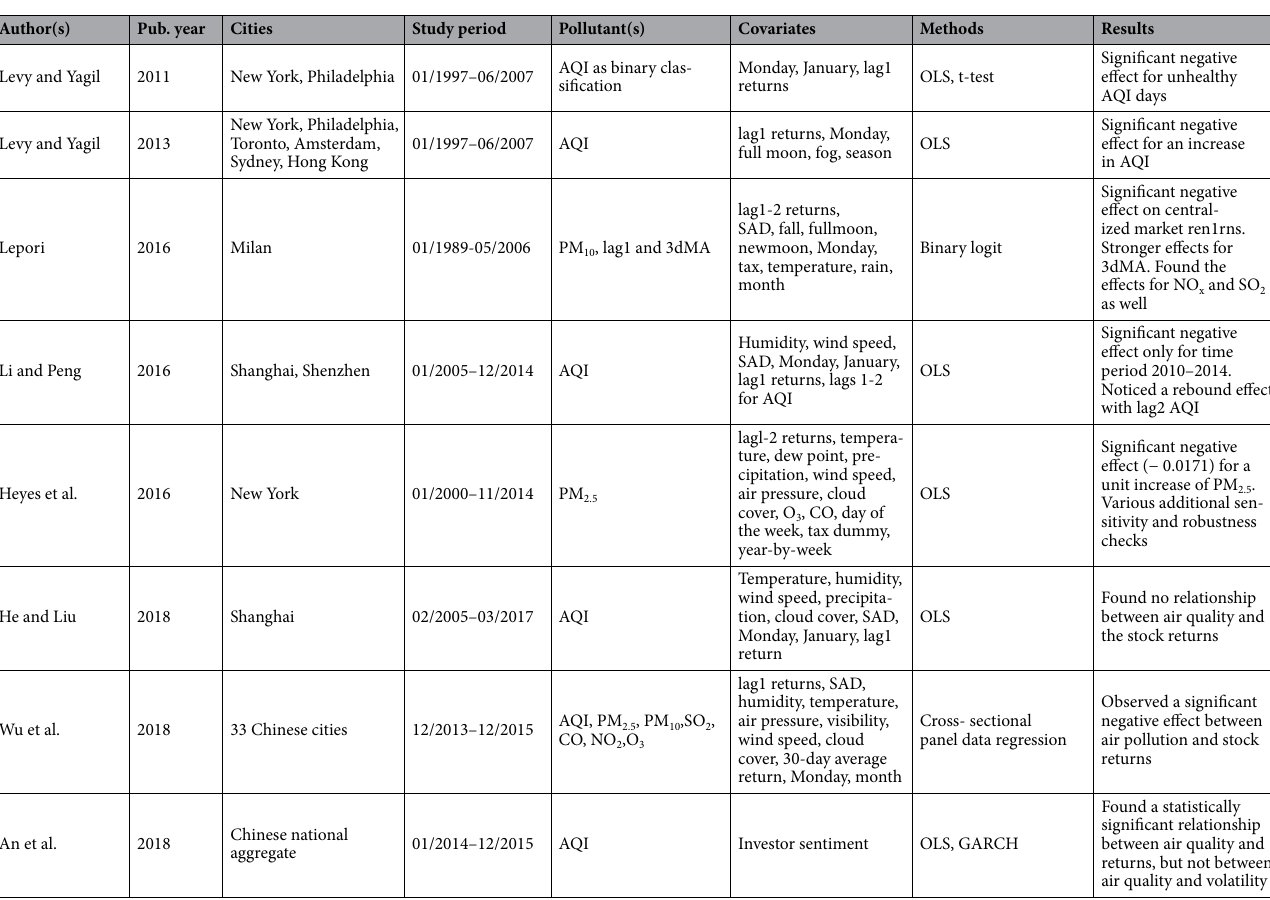
Table 1. Characteristics of the previous studies on the relation between daily air pollution levels and stock returns and